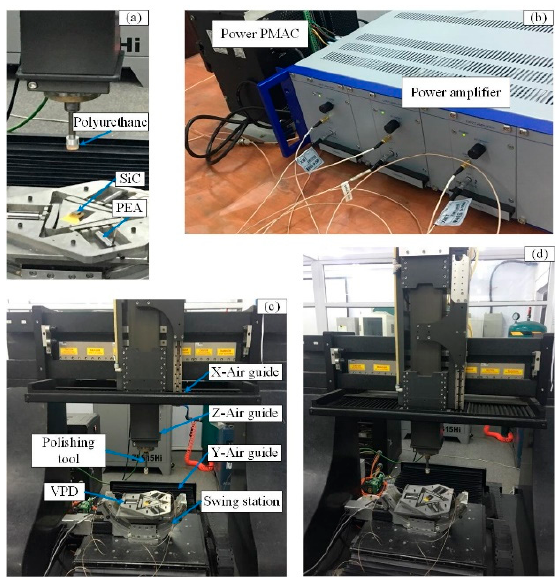
Figure 18. ( a ) Processing part, ( b ) signal control part, ( c ) the major part of the processing setup and ( d ) processing experiment setup of 3D RVMS.